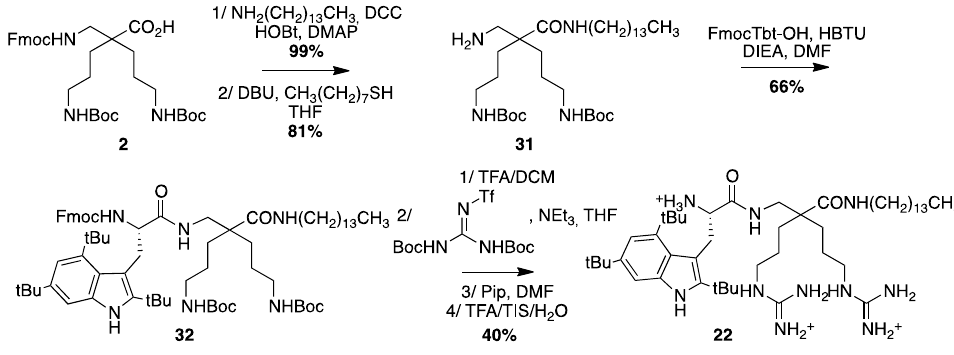
Figure 23 . HPLC profile of H-Tbt- β 2,2 h bis-Arg-NHBn 21 Figure 24 . H-Tbt- β 2,2 h bis-Arg-NH(CH 2 ) 13 CH 3 22 . Figure 24. H-Tbt- β 2,2 h bis-Arg-NH(CH 2 ) 13 CH 3 22 .